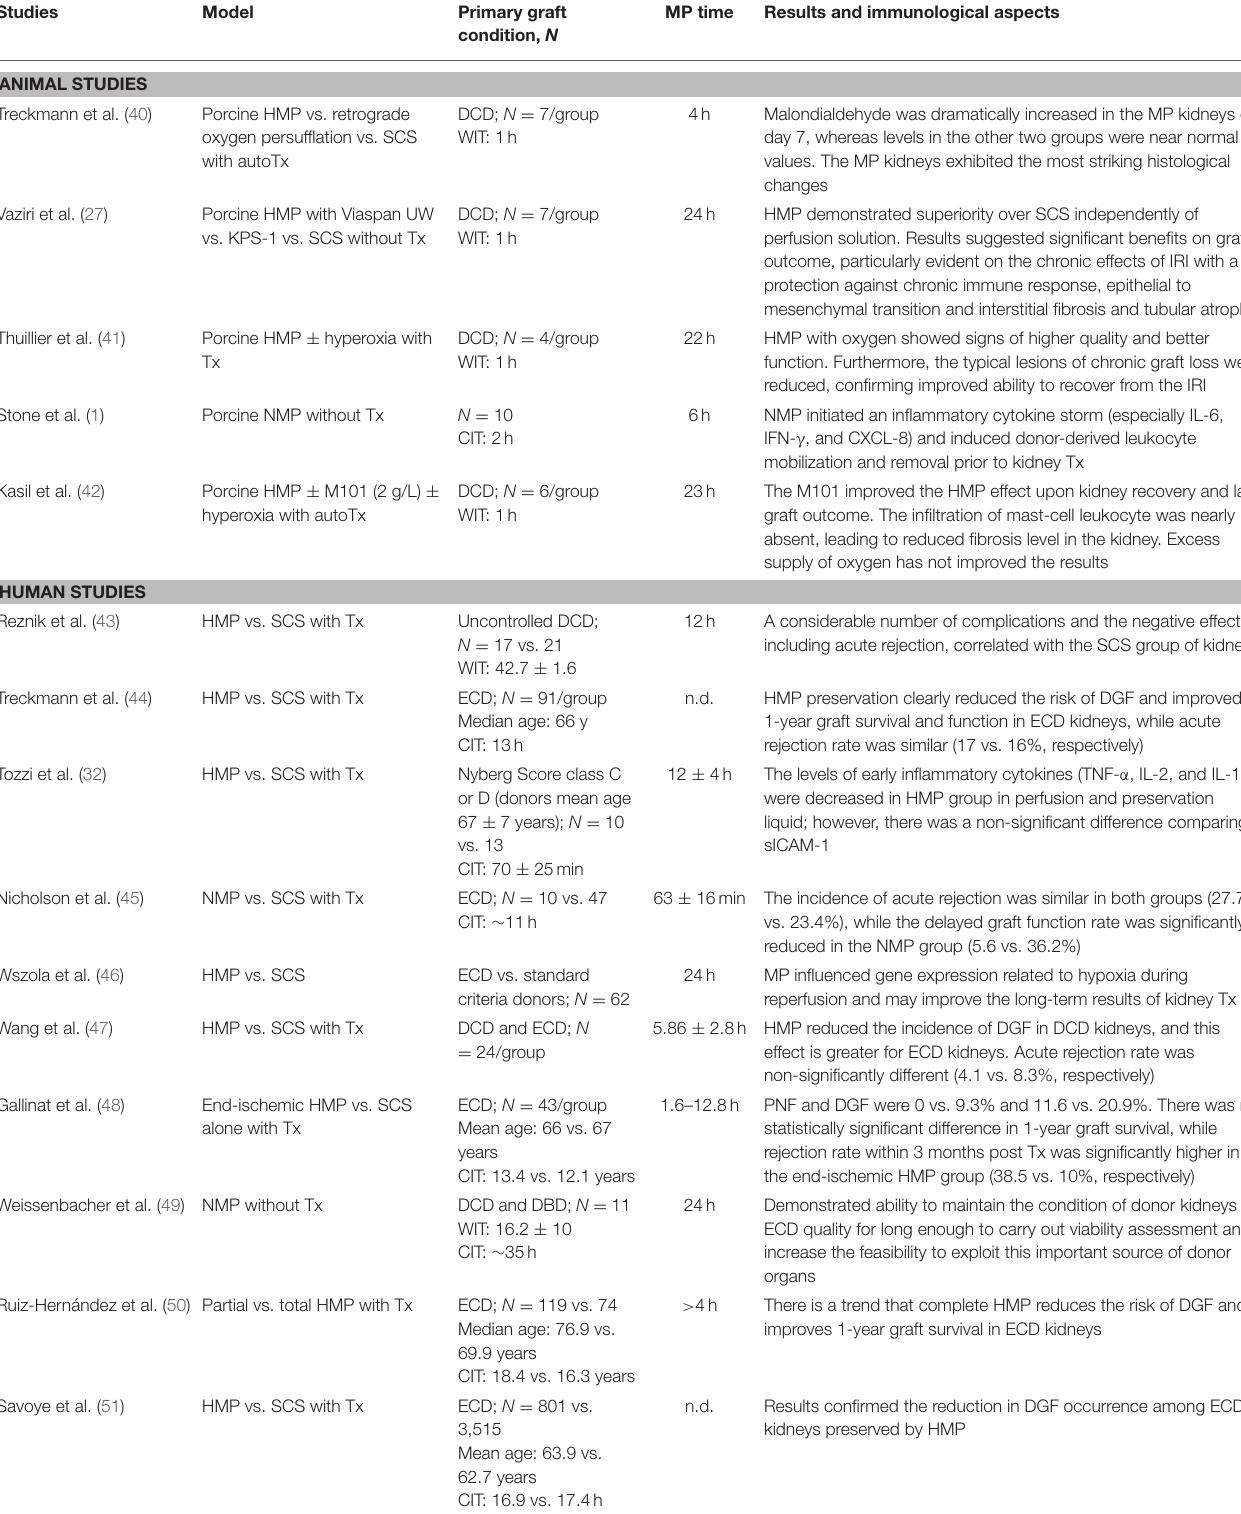
TABLE 1 | Experimental and clinical studies of machine perfusion of extended criteria donor kidney